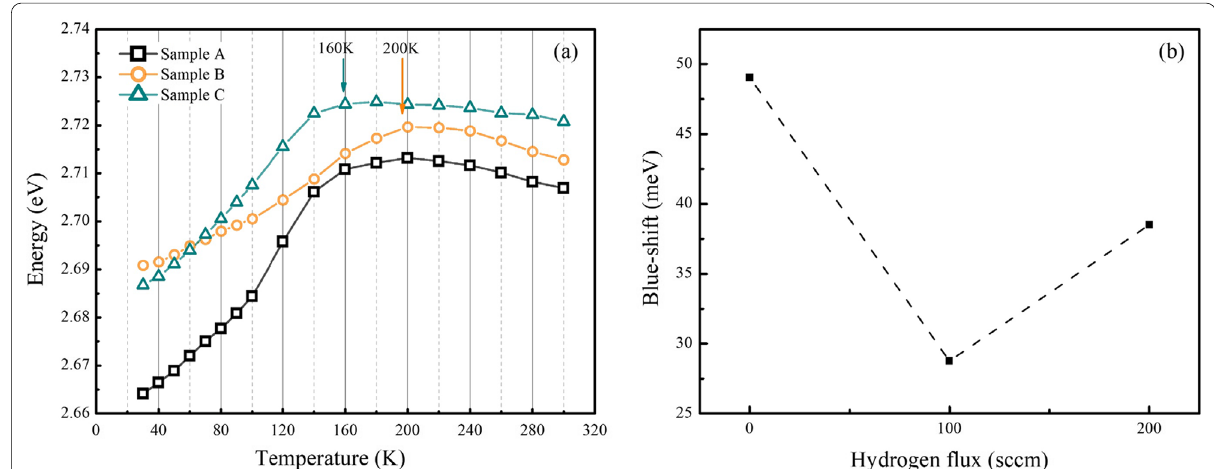
Fig. 5 a The curves of peak energy versus temperature for samples A, B and C; the arrows indicate the red shift turning temperature. b The amount of blue shift of samples A, B and C; and sample B has a lowest amount of blue shift